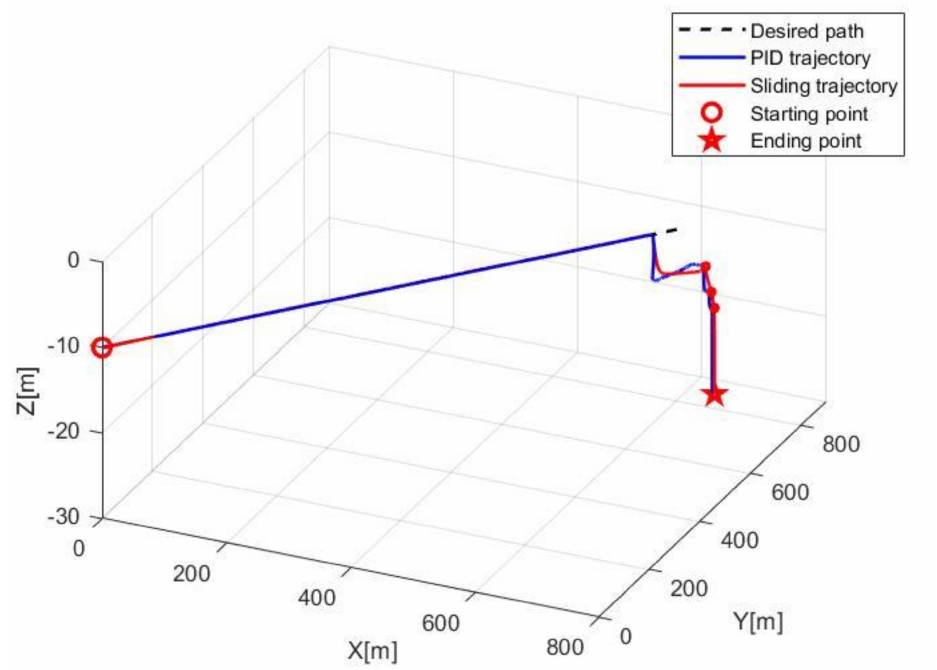
Figure 10. Homing and docking trajectory of the AUV.